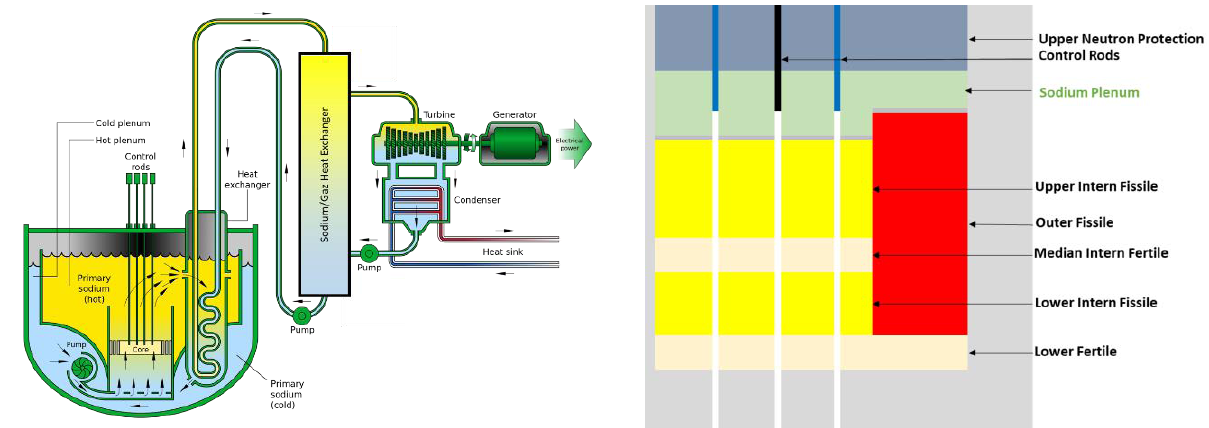
Figure 1 : Overview of ASTRID main circuits Figure 2 : ASTRID V3 - Axial core